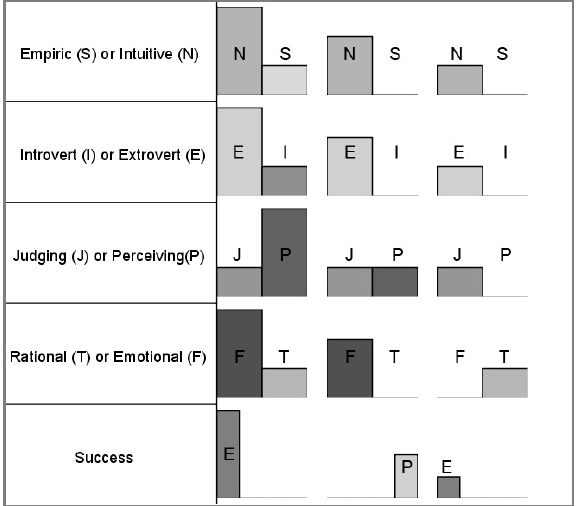
Fig. 5. Student profiles for course on